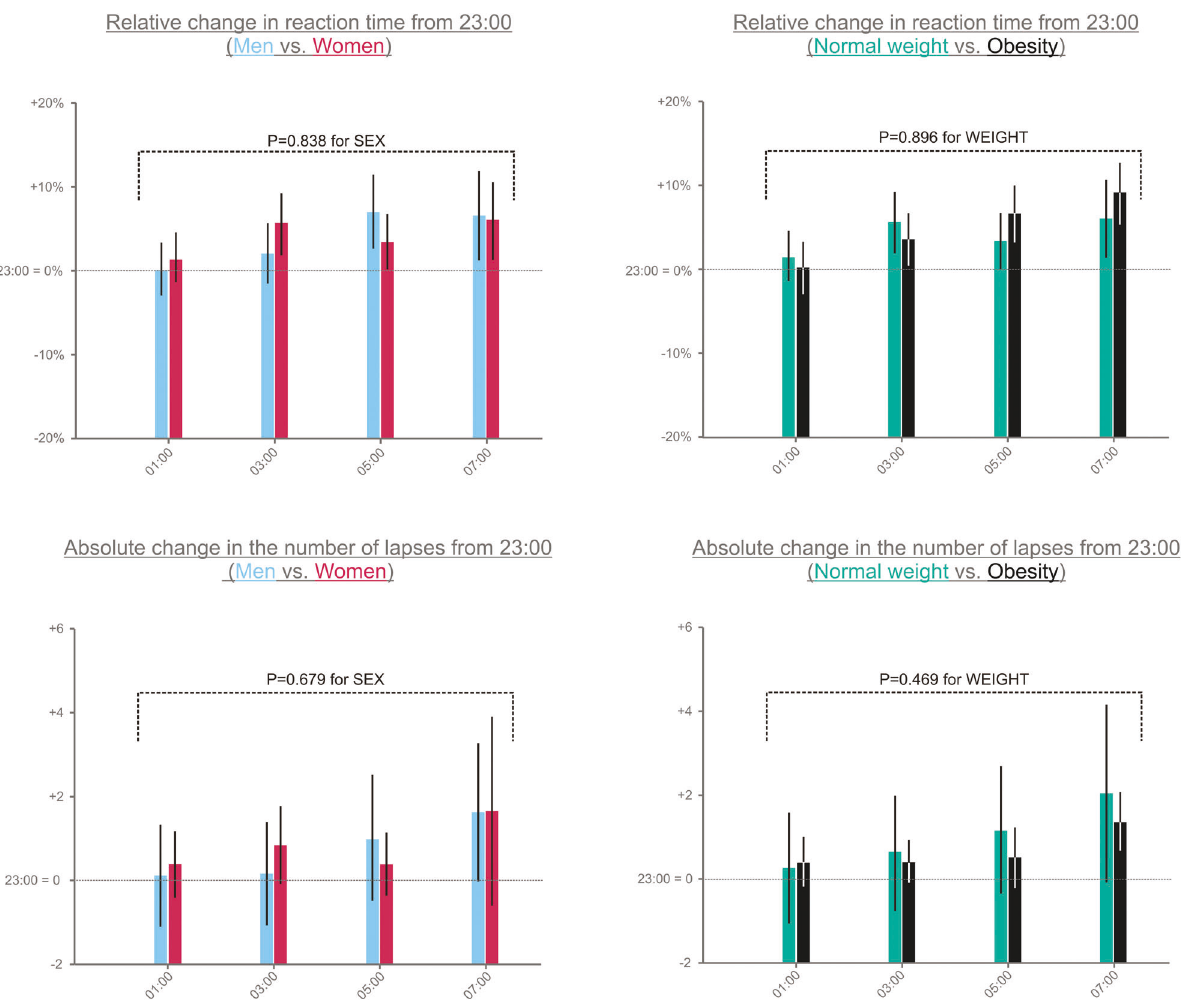
Fig. 3 Performance on the psychomotor vigilance task. Values are shown as estimated marginal means [95%-CI] as derived from generalized linear mixed models. Baseline (i.e., at 23:00) reaction time (mean ± SD): men, 314 ± 43; women: 330 ± 45; with normal weight: 323 ± 50; and with obesity: 318 ± 35. Number of lapses at baseline (mean ± SD): men, 1.6 ± 3.3; women: 1.8 ± 4.3; with normal weight: 2.5 ± 4.8; and with obesity: 0.6 ± 0.9. P < 0.05 was considered signi fi